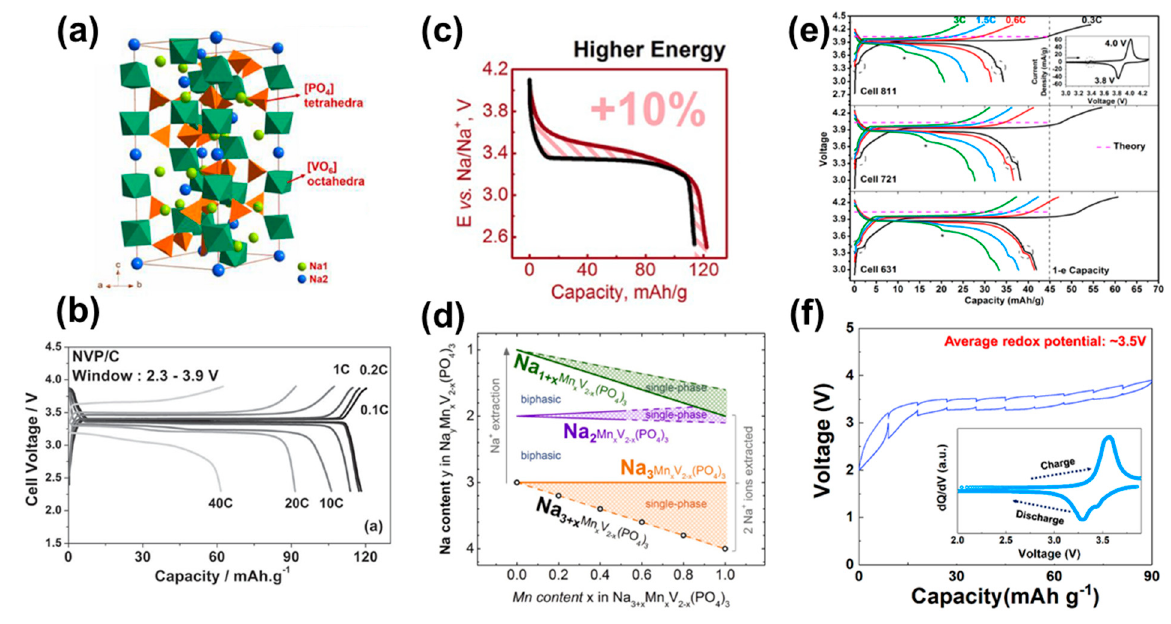
Figure 2. ( a ) Crystal structure of Na 3 V 2 (PO 4 ) 3 [50]. ( b ) Charge/discharge curves of Na 3 V 2 (PO 4 ) 3 /C at various current rates in the voltage range 2.3–3.9 V [51]. ( c ) Improvement of the specific energy (vs. Na + /Na) for Mn-doped Na 3 V 2 (PO 4 ) 3 . ( d ) Schematic diagram of the Na + deintercalation mechanism for Na 3+x Mn x V 2 − x (PO 4 ) 3 (0 ≤ x ≤ 1) during Na + extraction [57]. ( e ) Charge/discharge curves of Na 3 V 3 (PO 4 ) 4 at different current densities between 3.0–4.3 V. Inset is the relative CV profile at 0.05 mV s − 1 [23]. ( f ) The quasi-open-circuit potential profile of Na 3 V(PO 4 ) 2 tested at C/20 and calculated average voltage. Inset is the dQ/dV profiles of Na 3 V(PO 4 ) 2 [24].